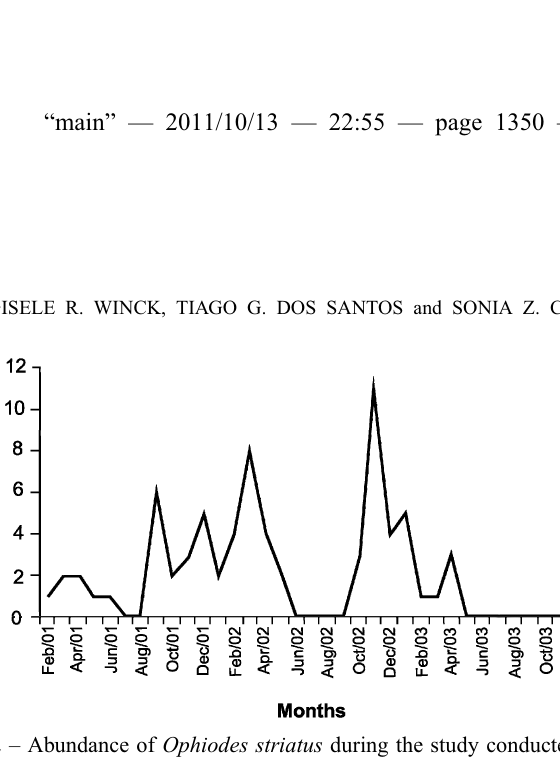
Fig. 2 – Abundance of Ophiodes striatus during the study conducted from February 2001 to January 2004, in an altered grassy field area, municipality of Santa Maria, Rio Grande do Sul state, Brazil.